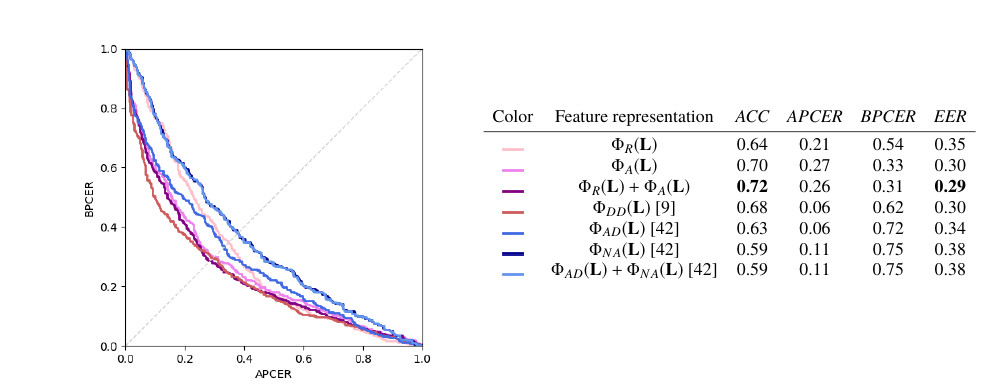
Figure 10. Results for different feature